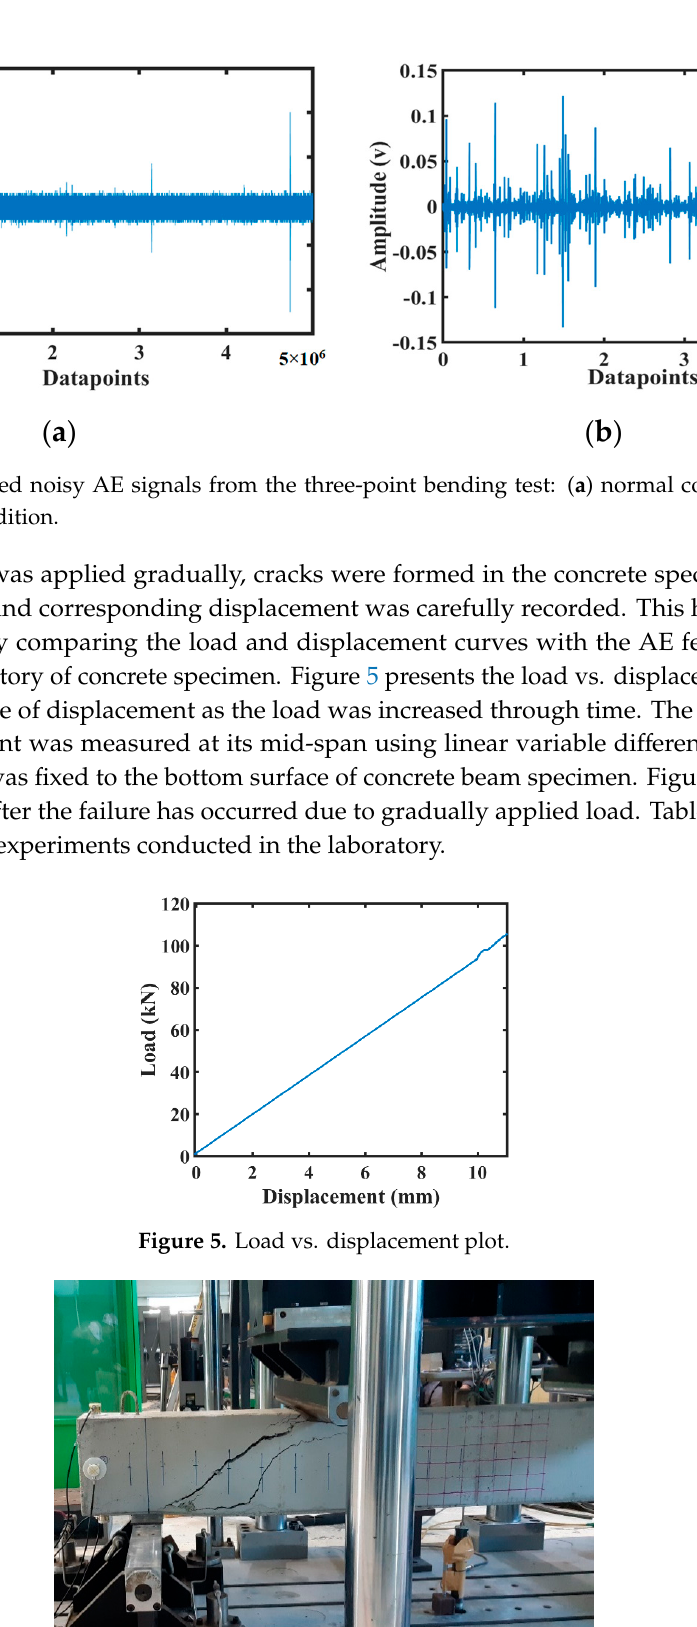
Figure 6. Severe fracture that took place after applying a gradually increasing load.